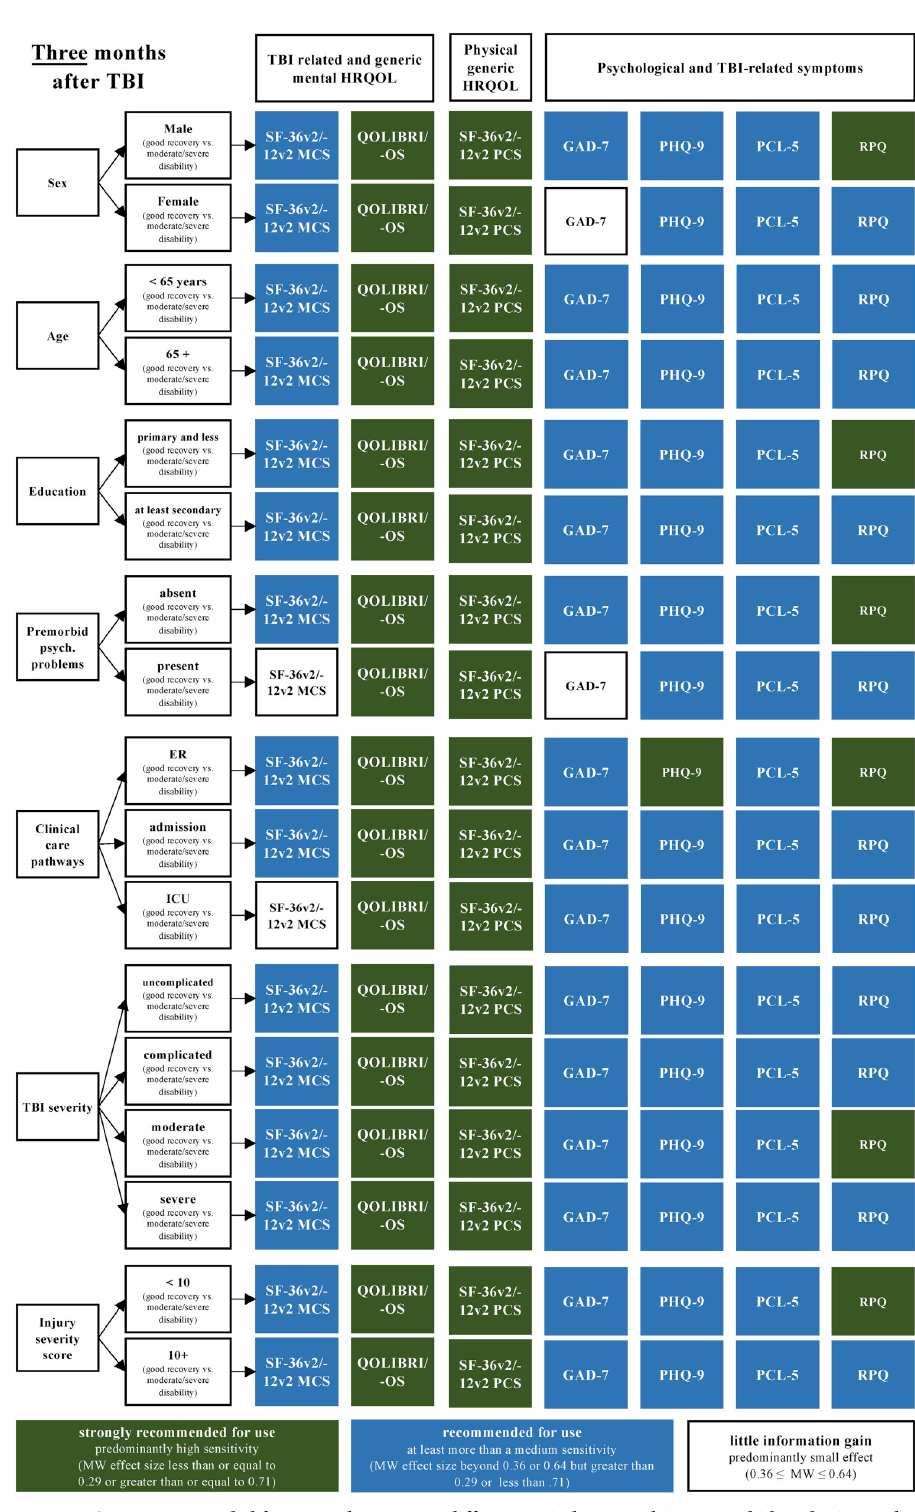
PLOS ONE | https://doi.org/10.1371/journal.pone.0280796 April 7,